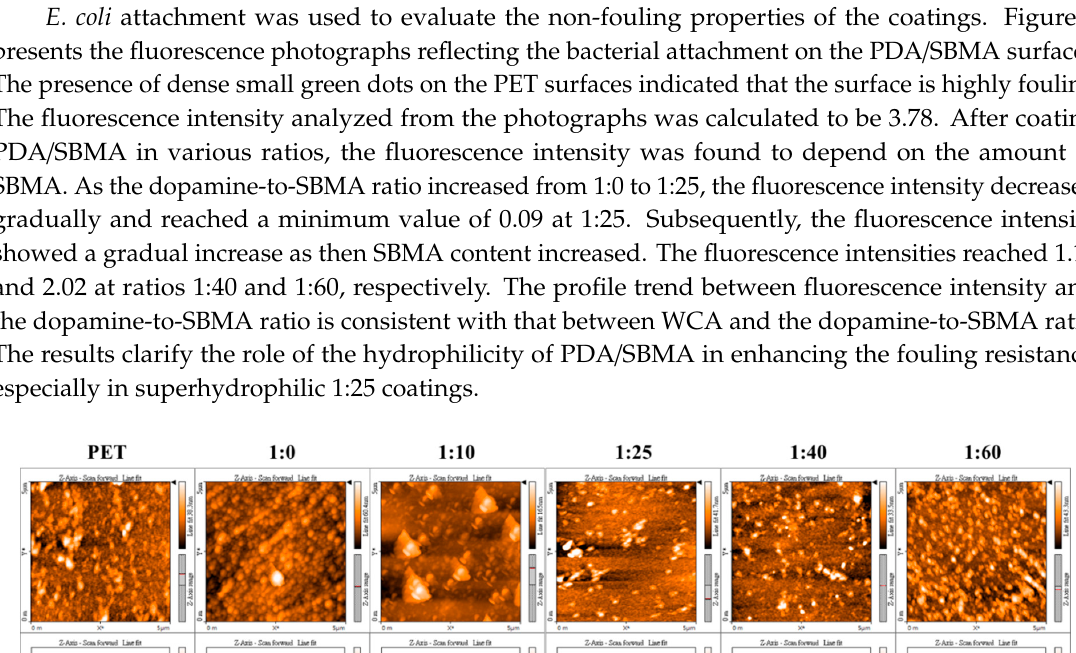
deposition, we further investigated the effect of the dopamine/SBMA ratio on the color of the solution